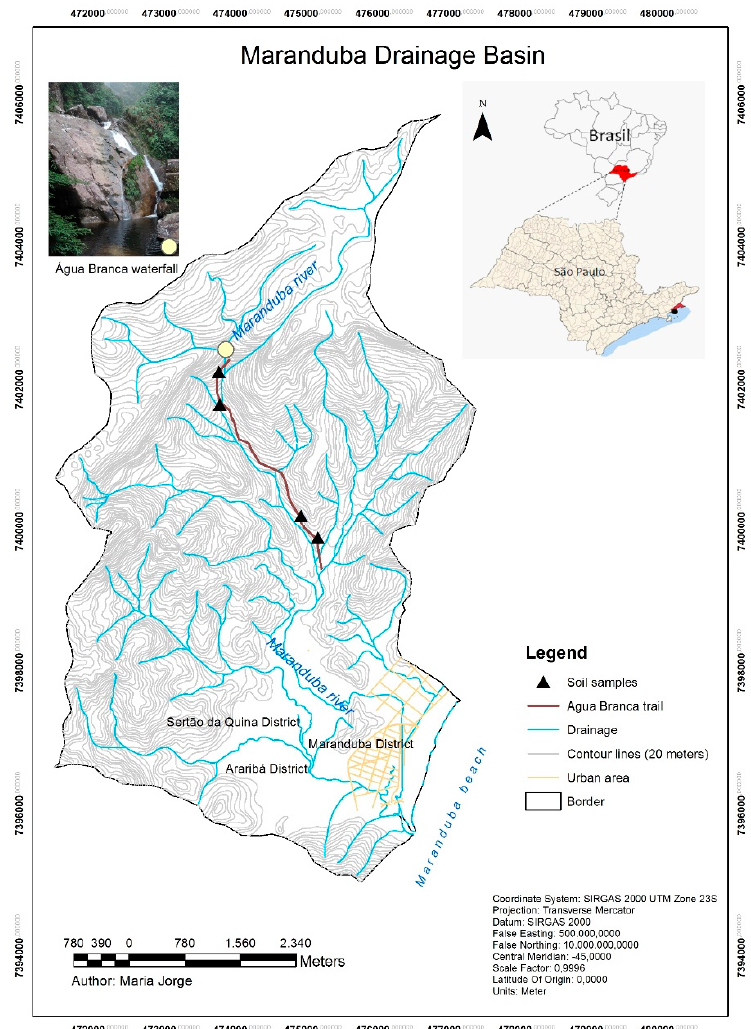
Figure 4. Água Branca trail in Maranduba drainage basin, Ubatuba Municipality. Figure prepared by Maria Jorge.